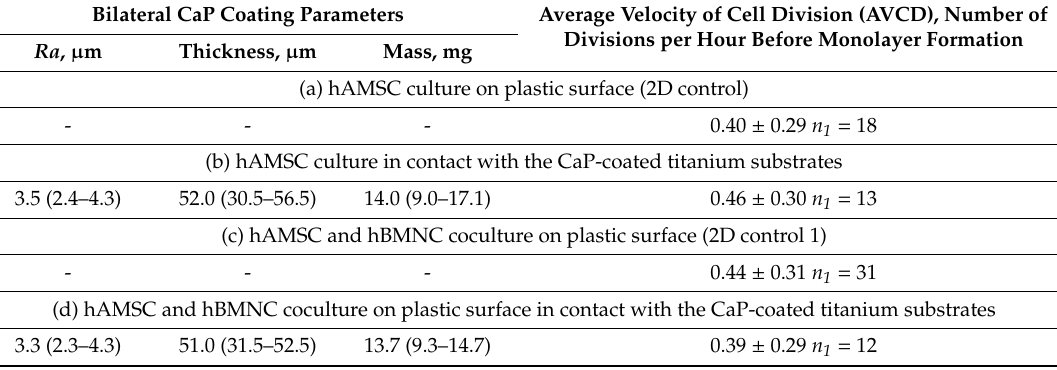
Table 3. Monitoring hAMSC division during 7-day culture without or with hBMNCs and / or the rough CaP coating, Me (Q1–Q3), X ± SD, n = 3.